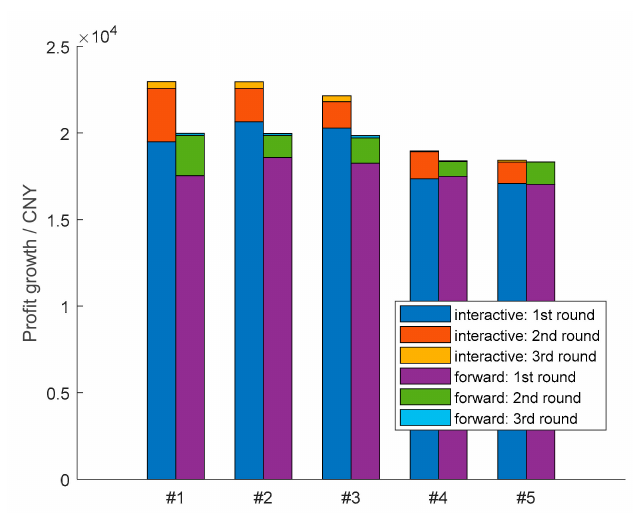
Figure 12. Profit growth in five di ff erent configurations of VPPs.